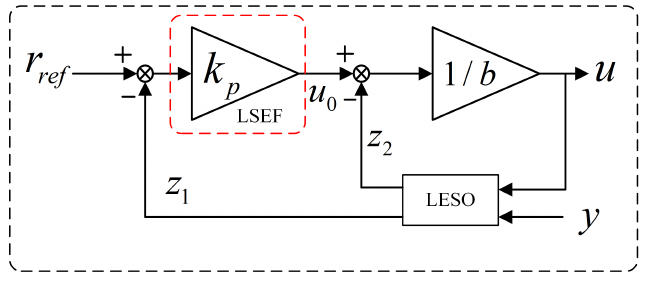
Figure 8. First order ADRC structure.